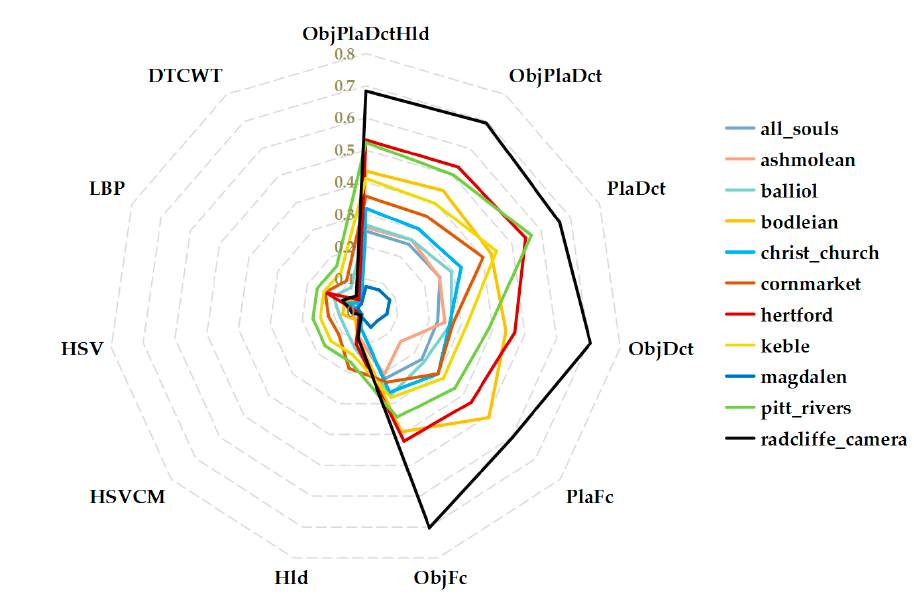
Figure 16. Radar chart of mAPs using different image retrieval methods on the Oxford 5K dataset.